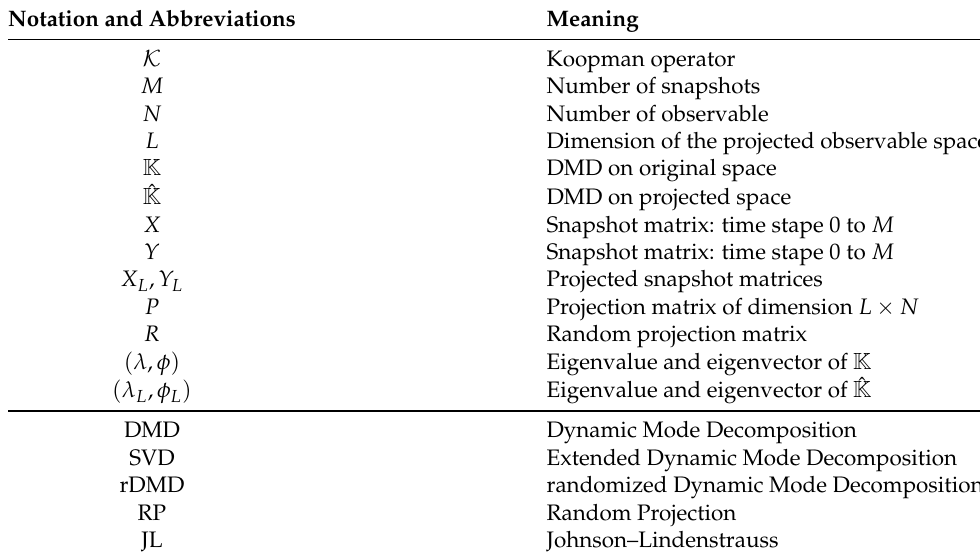
Table 1. Major notations and abbreviations used in the